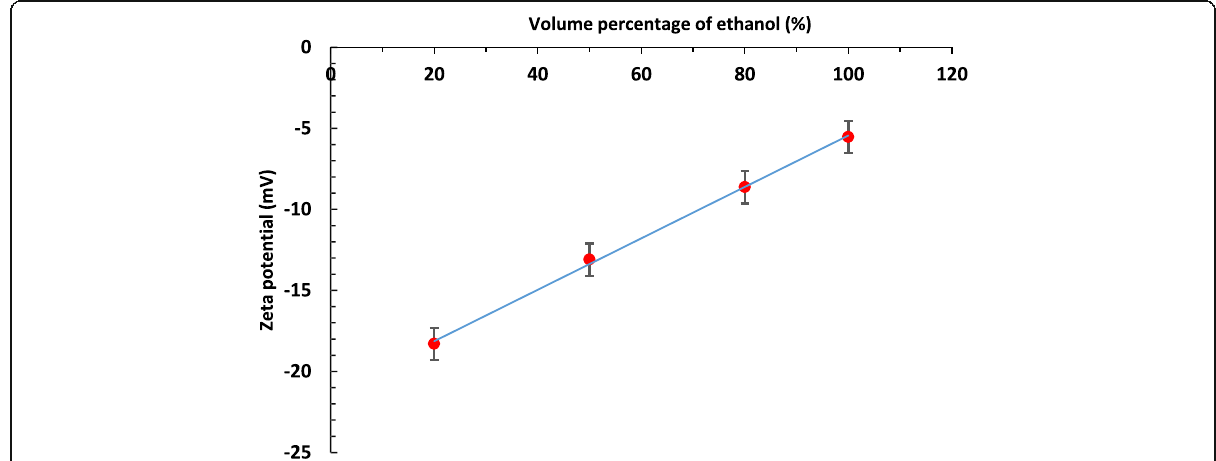
Fig. 5 Zeta potential values of PVP stabilized GNPs in 20%, 50%, 80% and 100% volume percentage of ethanol to water binary solvent